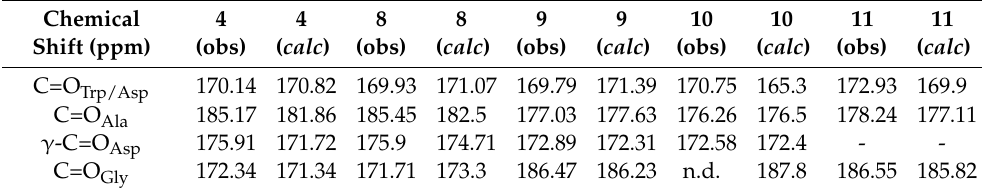
Table 4. Observed and assignment of 13 C NMR resonances for 4 , 8 – 11 and corresponding calcu- lated values.